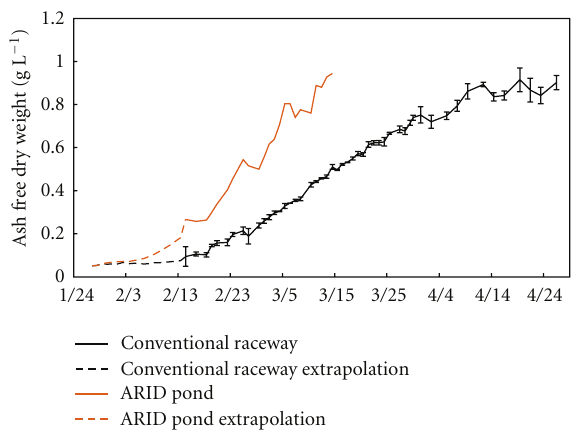
Figure 4: AFDW as a function of time for the ARID pond and triplicate conventional raceways. Batch phase growth ended on 3/14 for the ARID pond and 4/26 for the conventional raceways. The dashed regions were extrapolated with an OD 750 to AFDW correlation equation (AFDW = 0.225(OD 750 ) + 0.036) with an R 2 = 0 . 98.